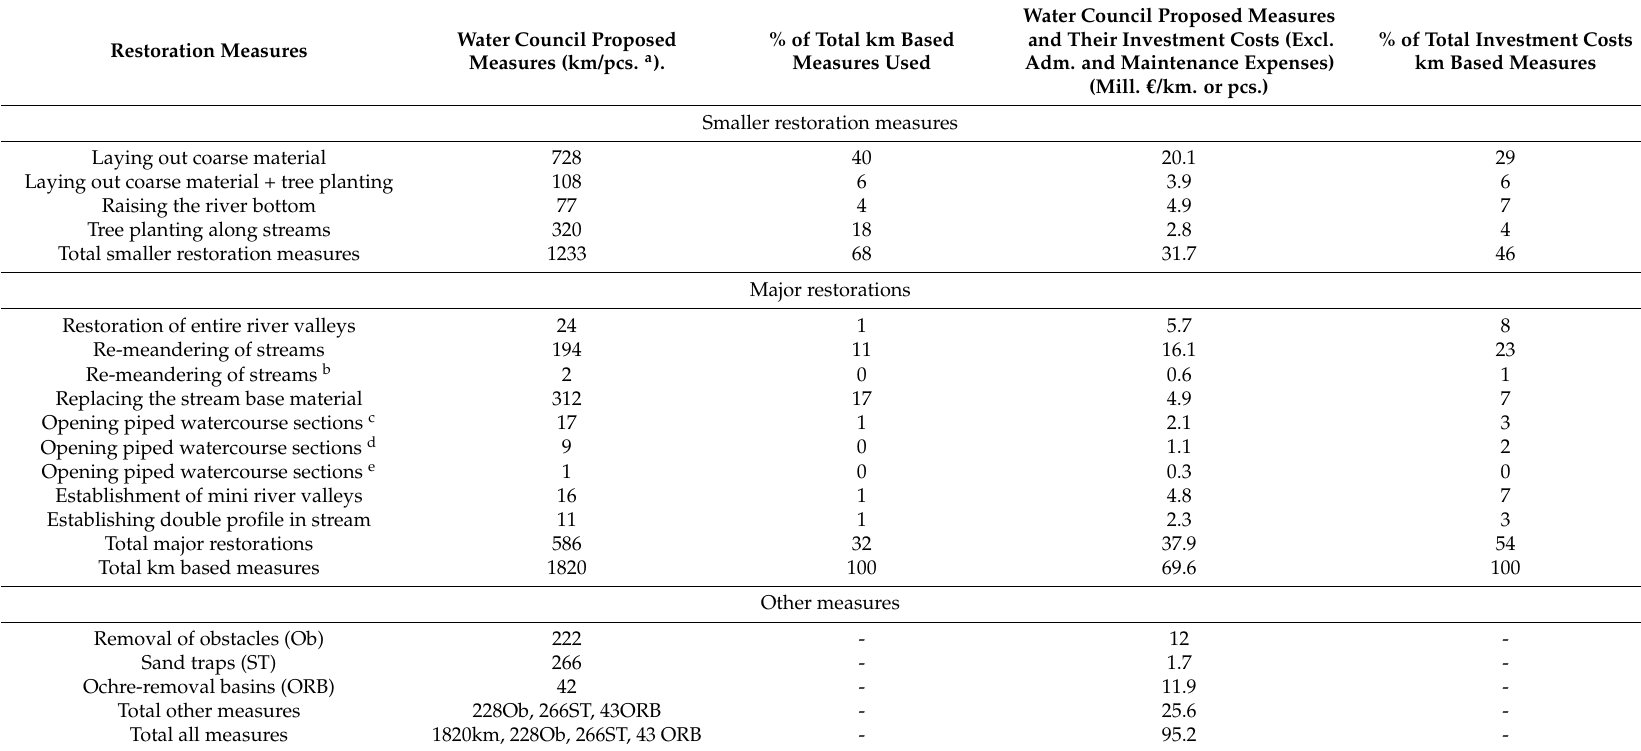
Table A2. Overview of the restoration measures proposed in all 23 RBDs, showing the number of km or pcs of streams, the associated costs and % of total